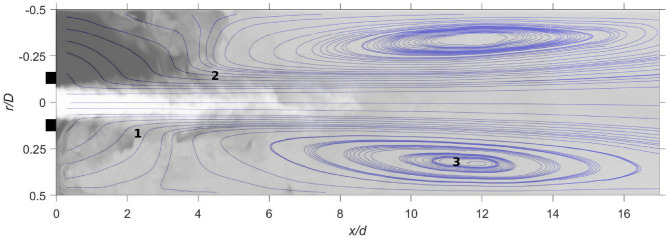
Streamlines for Case 2SC (Q = 0.5 and rc = 0) superimposed with an instantaneous scalar field of the mixture fraction. The black lines at the y-axis indicates cannula outlet position.